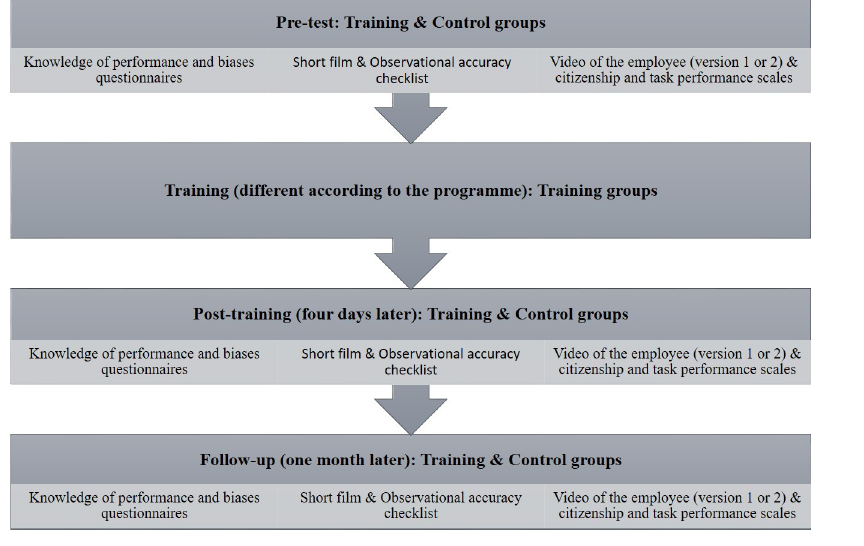
Fig 1. Phases of the procedure in studies 1 and